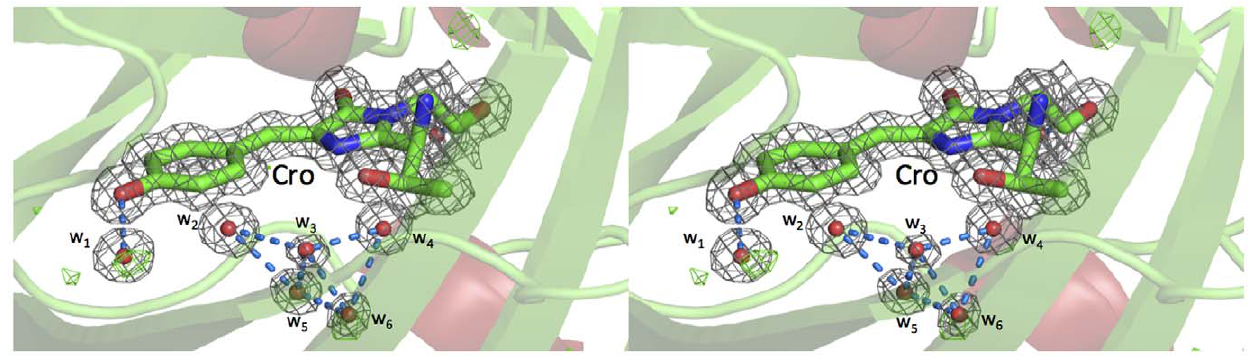
Figure 2. Chromophore local environment. Stereo view of the chromophore local environment with 2F o -F c electron density map contoured to 1 s , highlighting the presence of several conserved water molecules and hydrogen bonding interactions (blue dashed lines). Whilst waters W 1 to W 4 are present in both wt GFP and S65T GFP W 5 and W 6 are absent. W 1 to W 6 are all present in the lower resolution EGFP structure 2Y0G. W 1 to W 6 refer to solvent molecules 413, 442, 564, 421, 494 and 547 respectively in structure 4EUL.